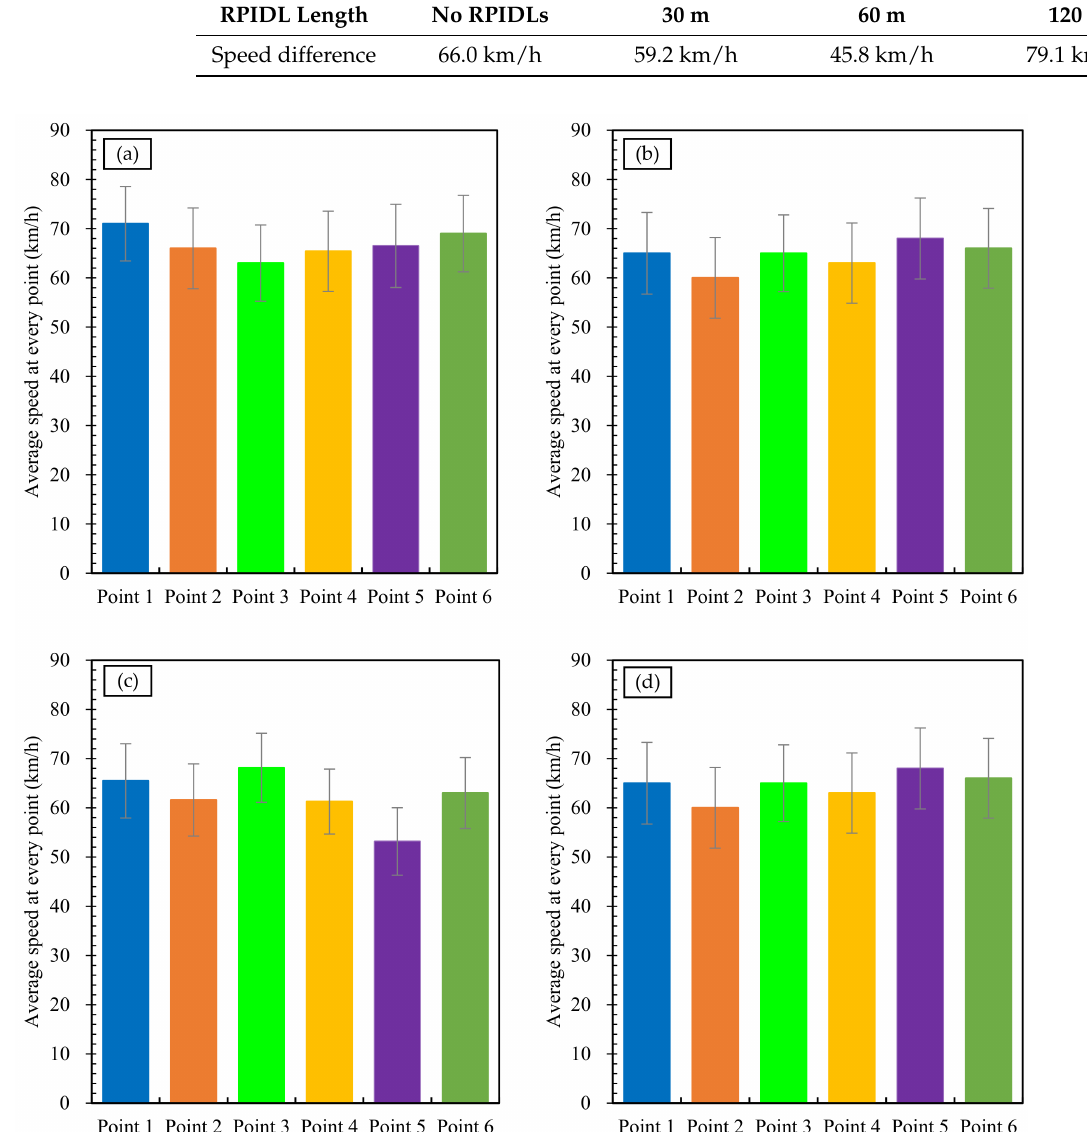
Figure 11. Average speeds of vehicle controlled by RPIDLs with different group lengths: ( a ) no RPIDLs; ( b ) 30 m; ( c ) 60 m; ( d ) 120